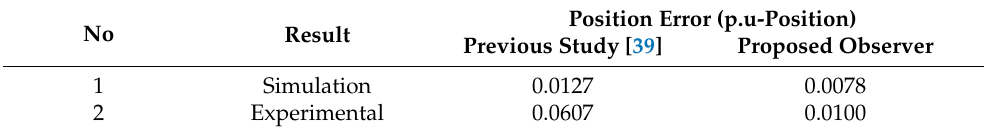
Table 5. Position error